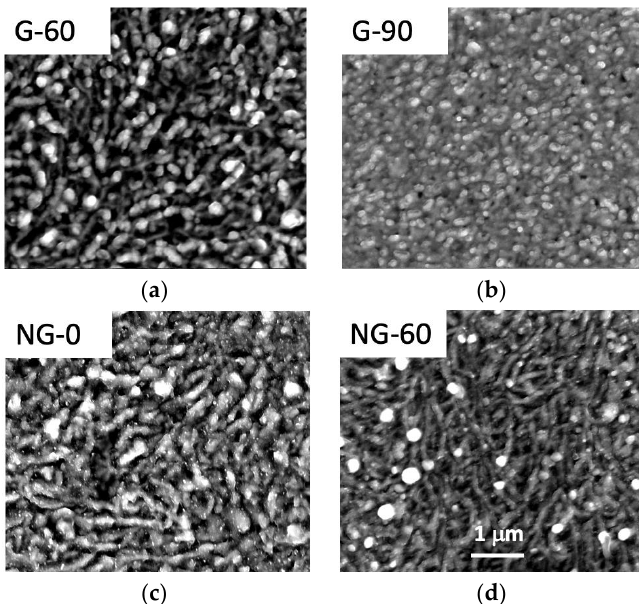
Figure 4. FEG-SEM images of ( a ) pure graphene with 60 mn post-deposition annealing; ( b ) pure graphene with 90 mn post-deposition annealing; ( c ) N-doped graphene with no post-deposition annealing; ( d ) N-doped graphene with 60 mn post-deposition annealing. The sub-micrometer texture was attributed to the texturing of the Ni catalyst film caused by thermal annealing. The four images are depicted with the same magnification 1 µm as noted on the image related to NG-60.